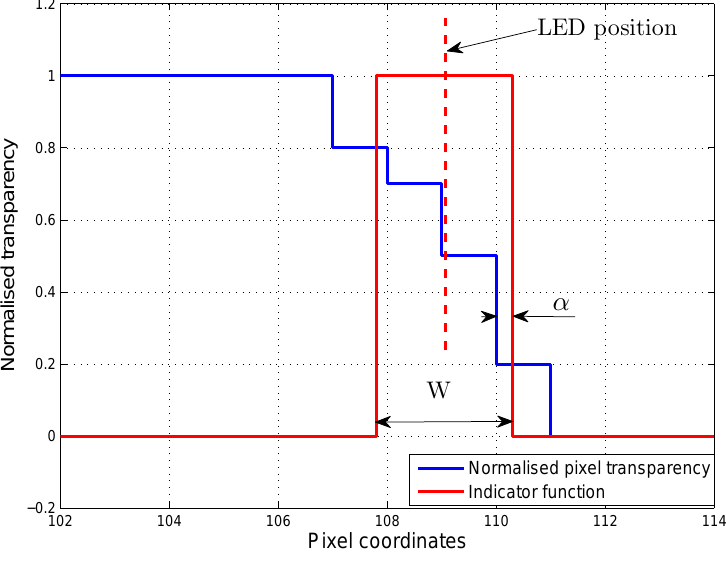
Figure 7. Light intensity measurement